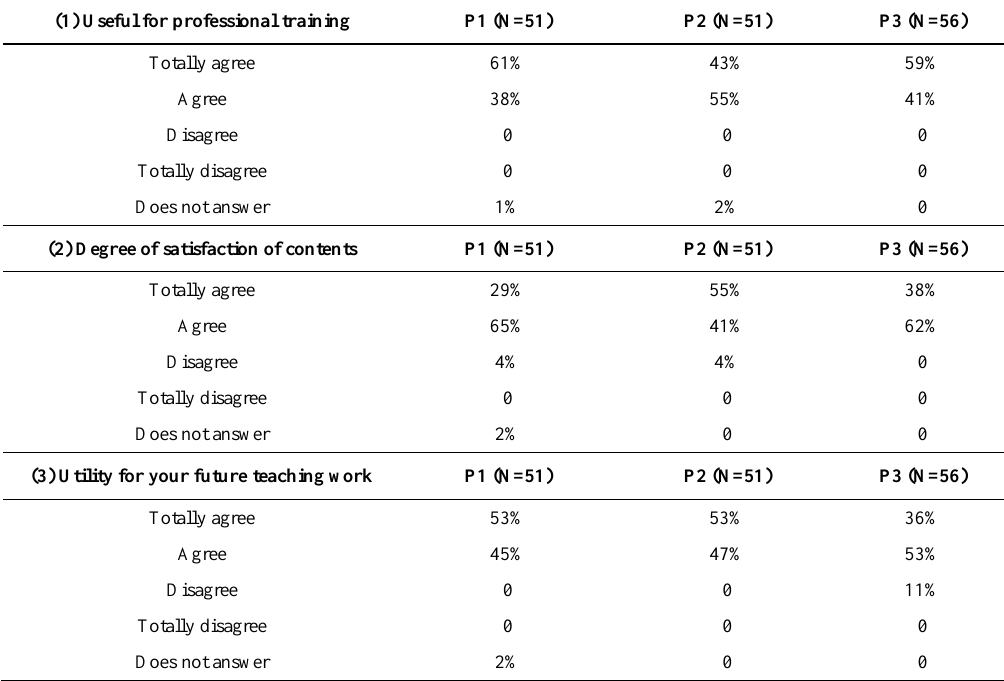
Table 1. Survey results. Perceptions from students after the practical work applied in DMN topic during the academic